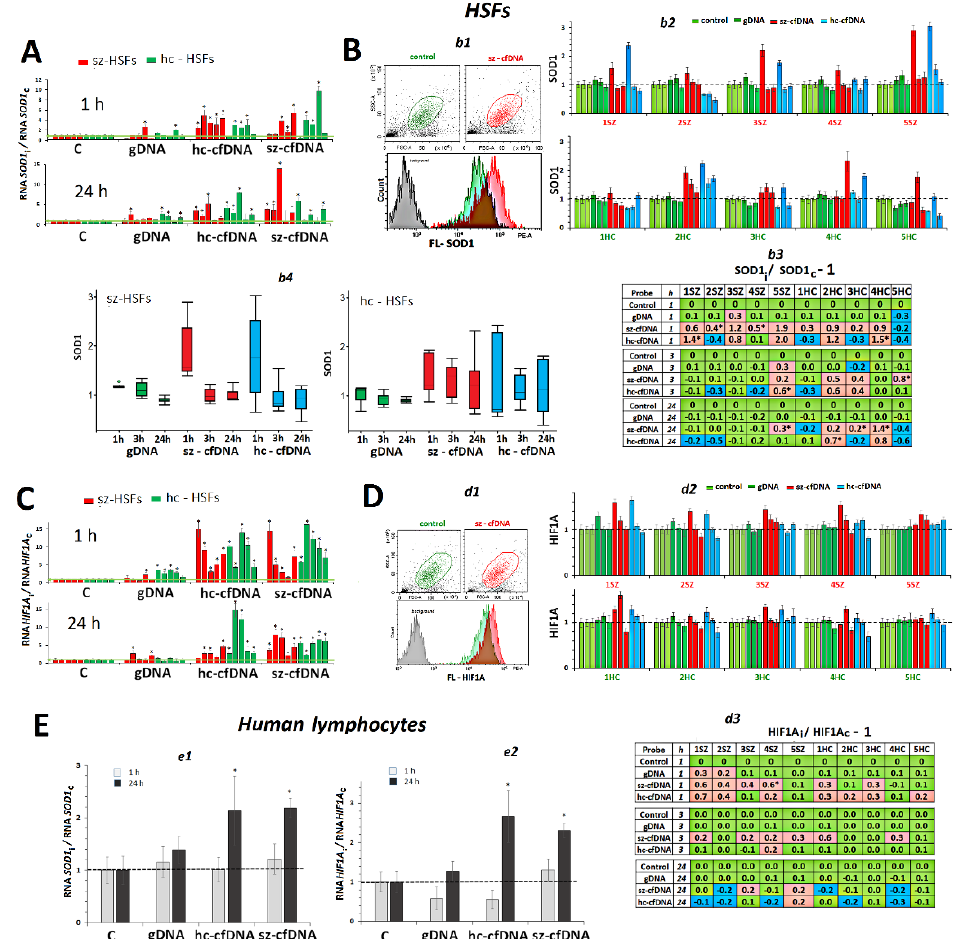
Figure 4. The influence of the DNA samples (50 ng/mL) on the expression of SOD1 and HIF1A genes in HSFs and PBL. ( A ). Change of the RNA SOD1 in HSFs. Average values for three measurements and standard deviation are given. The cultivation time and the DNA samples are indicated on the graph. The response to cfDNA differs from the control HSFs ( p < 0.01). ( B ). b1 —The most typical examples of the SOD1 assay with FCA in HSFs. The data from the device are given for sz-HSF3. b2 —Index SOD1: the values of the medians of FL-NRF2i, normalized to the control signal value. Average values for three measurements and standard deviation are given. b3 —Analysis of relative changes in SOD1 levels in the presence of DNA samples compared to control. Green color—no significant differences with the control ( p > 0.01), red—increased RNA content in the presence of the DNA probe ( p < 0.01) and blue—decreased RNA content ( p < 0.01). b4 —Changes in the SOD1 index in sample of sz-HSFs (n = 5) and hc-HSF(n = 5). ( C ). Change of the RNA HIF1A in HSFs. Average values for three measurements and standard deviation are given. The cultivation time and the DNA samples are indicated on the graph. (*) The response to cfDNA differs from the control HSFs ( p < 0.01). ( D ). d1 —The most typical examples of the HIF1A assay with FCA in HSFs. The data from the device are given for sz-HSF3. d2 —Index HIF1A: the values of the medians of FL-NRF2i, normalized to the control signal value. Average values for three measurements and standard deviation are given. d3 —Analysis of relative changes in HIF1A levels in the presence of DNA samples compared to control. Green color—no significant differences with the control ( p > 0.01), red—increased RNA content in the presence of the DNA probe ( p < 0.01) and blue—decreased RNA content ( p < 0.01). ( E ). e1 and e2 —Change of the RNA SOD1 and RNA HIV1A in the PBL in the presence of DNA samples (50 ng/mL). Average values for four lymphocyte samples and standard deviation are given. PBL . The lymphocyte response to the action of DNA samples differed from the re- sponse of HSFs by a delayed increase in the SOD1 gene expression (Figure 4E e1 ). The hc- cfDNA and sz-cfDNA samples stimulated an increase of SOD1 RNA level in 24 h of cul- tivation only. The gDNA sample had practically no effect on SOD1 expression.